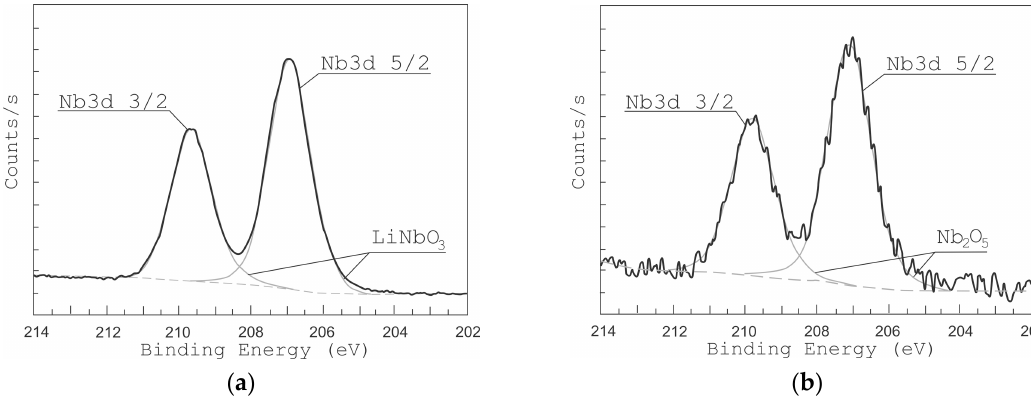
Figure 6. XPS peaks from Nb of LiNbO 3 films grown at different oxygen pressures: 1 × 10 − 2 Torr ( a ) and 1 × 10 − 5 Torr ( b ).